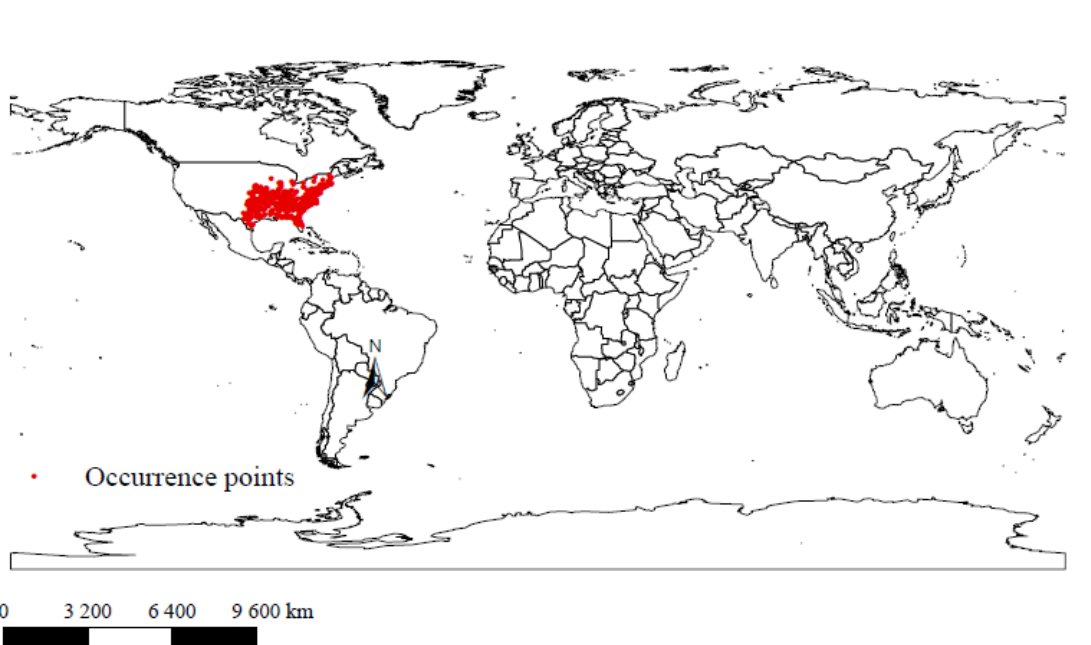
Figure 1. The output of the Maxent model’s for the training omission rate and predicted area as a function of the cumulative threshold.